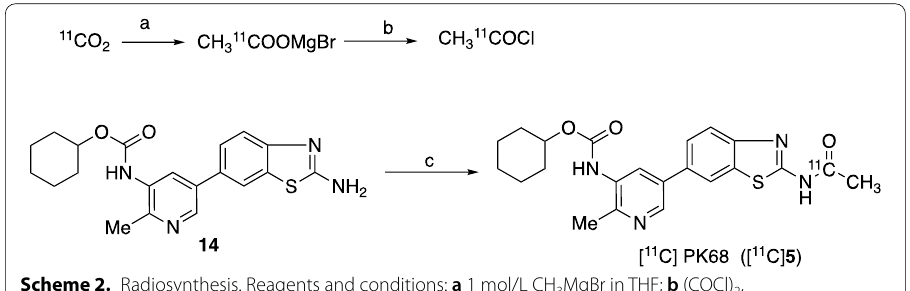
noma (B16F10)-bearing mice treated with PK68 exhibit a significant reduction in the number of tumor metastases that is the same as in B16F10-bearing mice treated with Necrostatin-1 ( 1